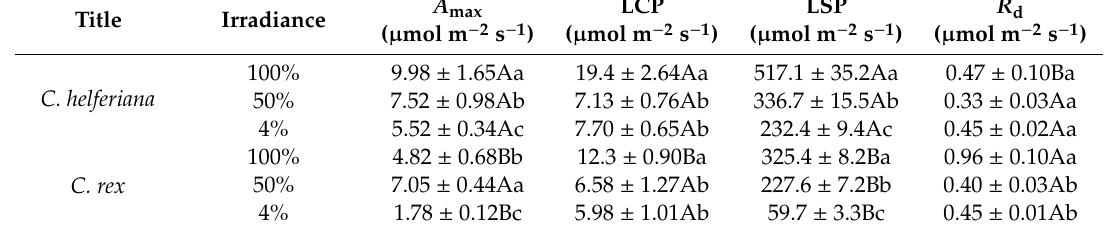
(Table 1, Figure 2). Under 100% sunlight, A max , LCP and LSP of C. helferiana were 107%, 57% and 59% higher, respectively, than those of C. rex , while R d was 49% of C. rex . There was no significant difference in A max , LCP, LSP and R d between the two species under 50% sunlight. Under 4% sunlight, A max and LSP of C. rex were significantly higher than those of C. helferiana , which were 2.1 and 2.9 times higher, respectively, but there was no significant difference in LCP and R d (Table 1). In general, the maximum net photosynthetic rate, light compensation point and light saturation point of C. helferiana were higher than those of C. rex with few exceptions under the deep shade treatment. Table 1. Results of photosynthetic light response curves of C. helferiana and C. rex seedlings grown under three di ff erent light conditions. Data are means ± 1SE ( n = 4). Di ff erent capital letters following the values indicate significant di ff erence ( p < 0.05) between species under the same light intensity, and di ff erent lowercase letters indicate significant di ff erence ( p < 0.05) between di ff erent light intensities within the species. A max , maximum photosynthetic net CO 2 assimilation rate; LCP, light compensation point; LSP, light saturation point; R d , dark respiration rate.